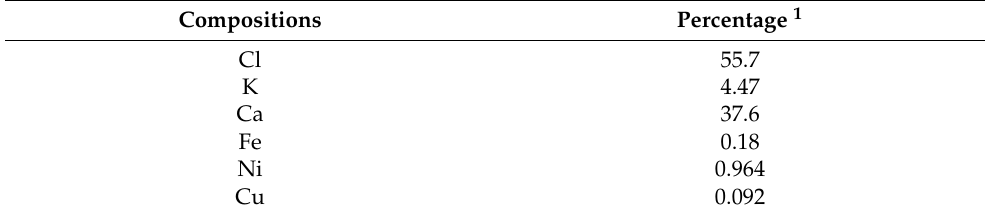
Table 4. Chemical composition of the